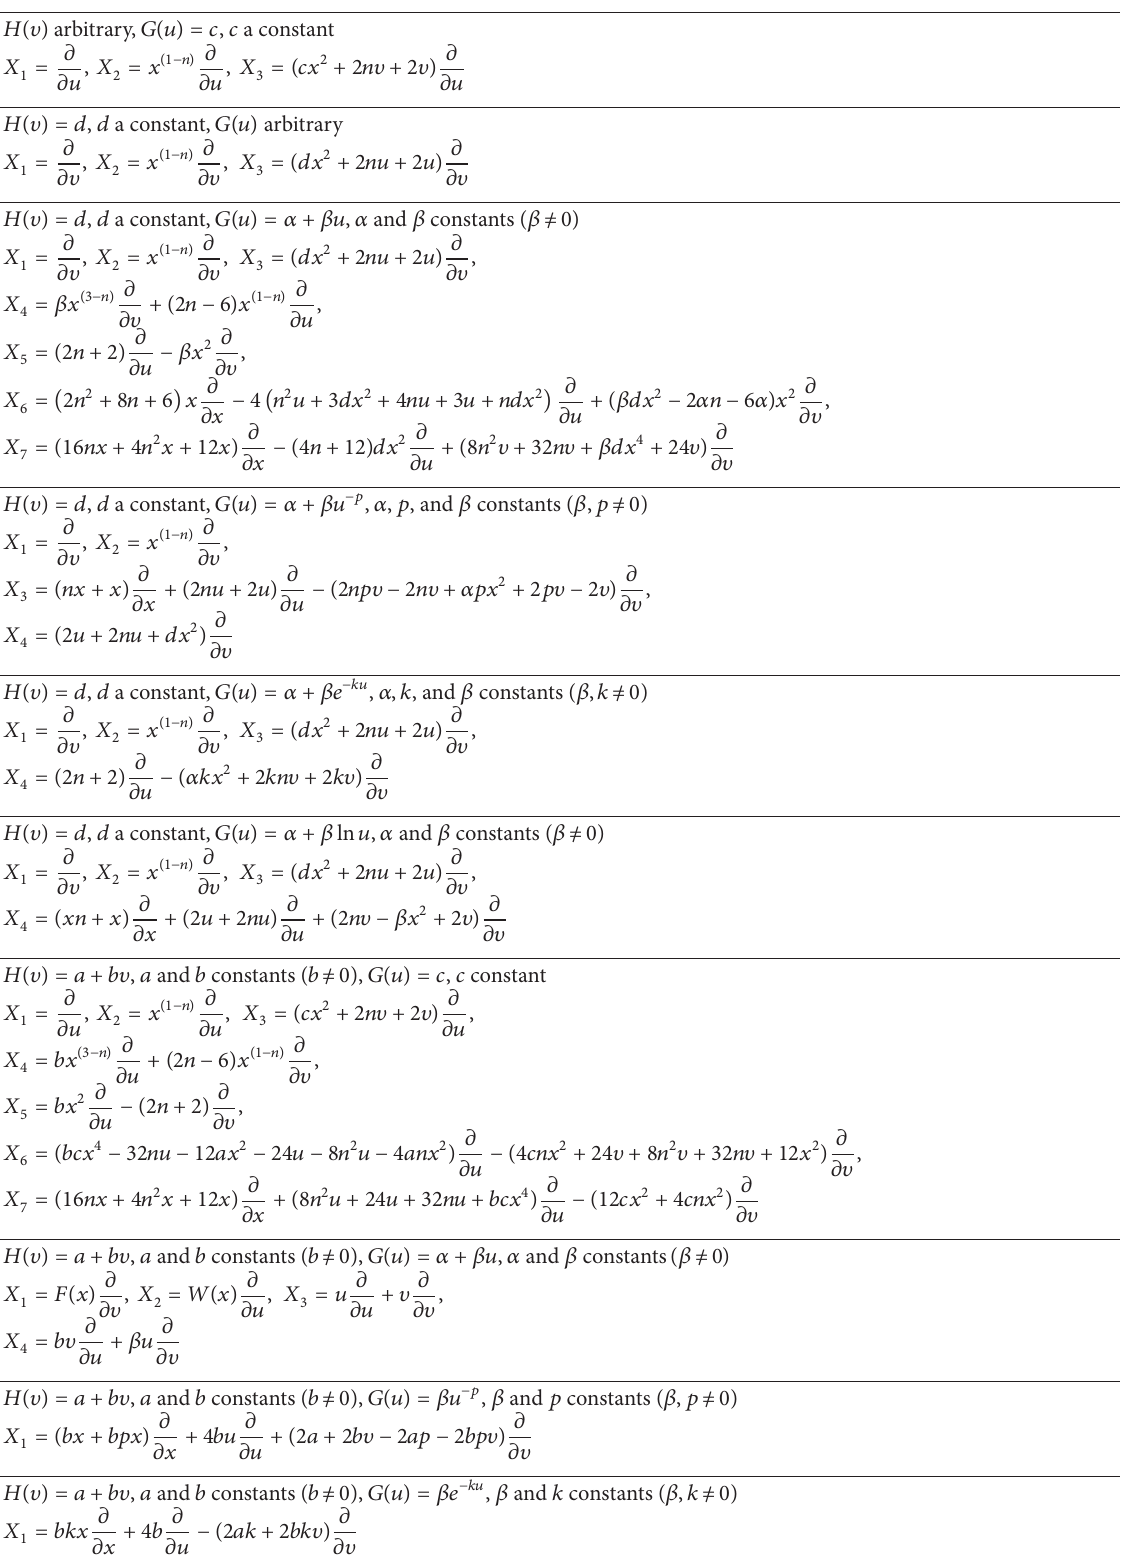
Table 1: Lie symmetries for 𝑛 ̸= − 1, 1,3 , for various functions 𝐻(𝑣) and 𝐺(𝑢) . 𝐻(𝑣) arbitrary, 𝐺(𝑢) = 𝑐 , 𝑐 a